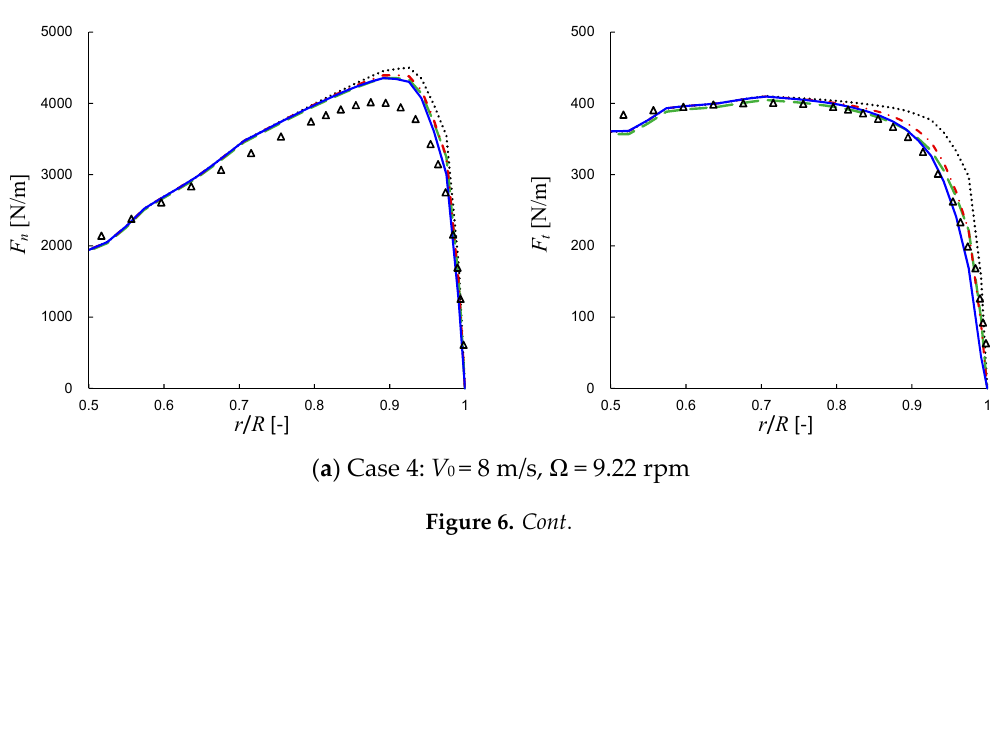
( b ) Case 5: V 0 = 11.4 m/s, Ω = 12.06 rpm Figure 6. Normal force F n and tangential force F t along the NREL 5MW blade. 6.1.2. Comparison with BEMT Results The Glauert tip loss correction was originally proposed for BEMT. As applied to AD/NS simulations, the correction factor F works in a different way. It is worth to mention that the specific difference in the final results would be caused by the transplantation from BEMT to AD/NS. In